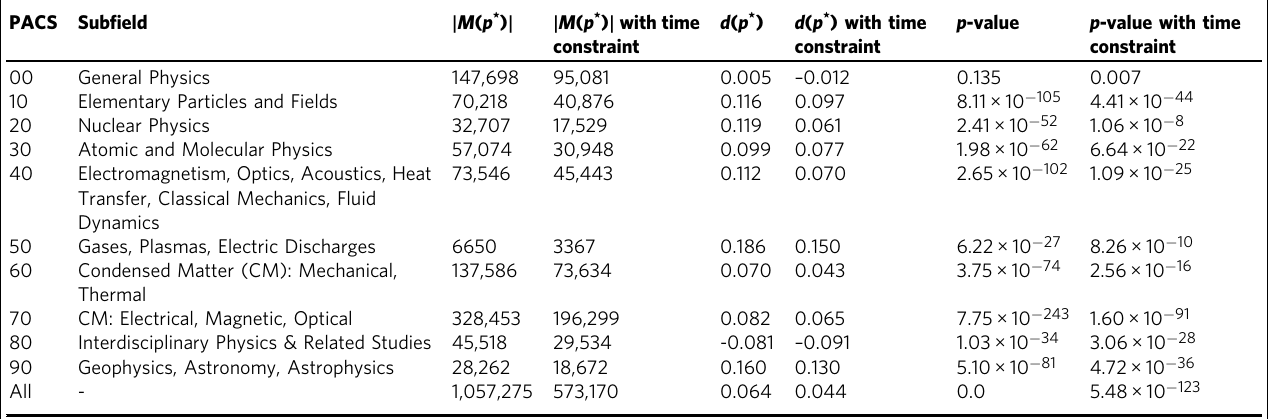
Table 1 Differences in received citations among similar pairs of publications labeled by their fi rst-author